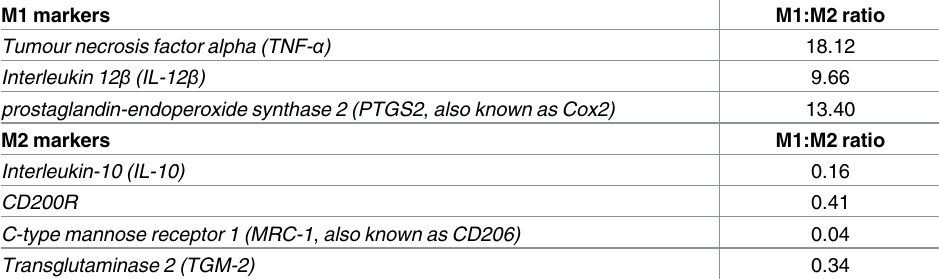
C-type mannose receptor 1 (MRC-1 , also known as CD206) Transglutaminase 2 (TGM-2) M1: M2 ratio of mean fold change of each M1 or M2 specific macrophage marker in healthy human peripheral blood MDM. M1 phenotype MDM were generated by stimulation of MDM with 10ng/mL LPS plus 20ng/mL IFN γ for 24 hours, and M2 phenotype MDM generated by stimulation of MDM with 20ng/mL IL-4 for 24 hours ( M2 ). Values are expressed to nearest 2 decimal places and presented as mean fold change for 5 independent